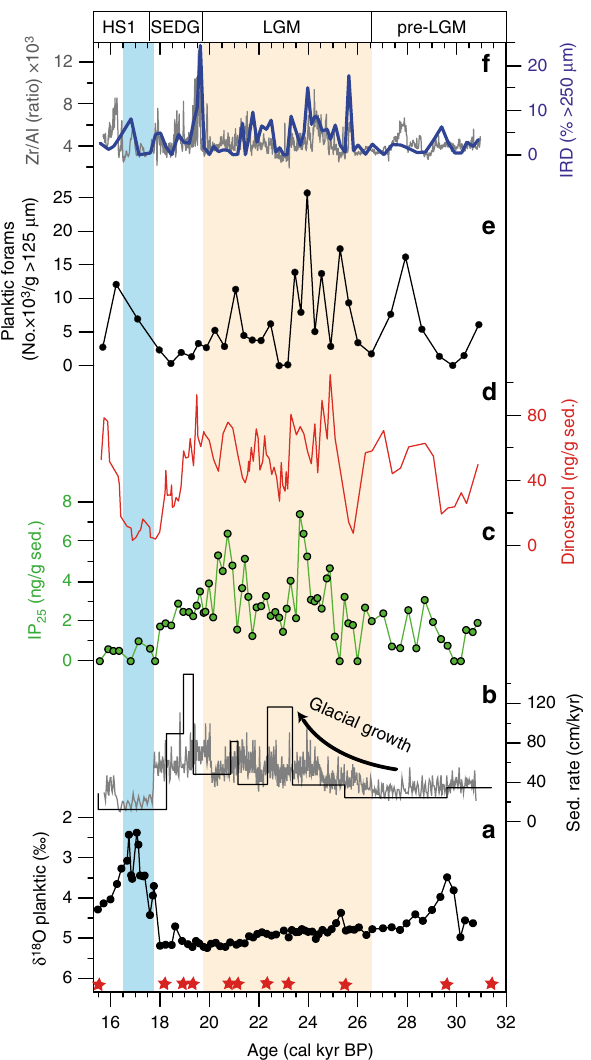
Fig. 5 Proxy data of sediment cores GC14-190-01PC for the late glacial period (ca. 31 – 15 cal. kyr BP). a Planktic δ 18 O ( ‰ ) measured on Neogloboquadrina pachyderma sin. b Sedimentation rates (cm/kyr) inferred from Bayesian age-depth modeling (Bacon v2.2) (black line) and linear interpolation (gray line) between 11 AMS 14 C dates (red asterisks at bottom). c IP 25 concentration (ng/g Sed) (green dots). d Dinosterol concentration (ng/g Sed). e Number of planktic foraminifera in coarse fraction (>125 µ m) in thousands. f Ice rafted debris (IRD) inferred from % of >250 µ m coarse fraction (blue line) and XRF based Zr/Al ratio (gray line). HS1: Heinrich Stadial 1, SEDG: Shelf Edge Deglaciation, LGM: Last Glacial Maximum (beige colored) 19 . The bluish rectangle marks the freshwater release during Svalbard Barents Sea ice sheet